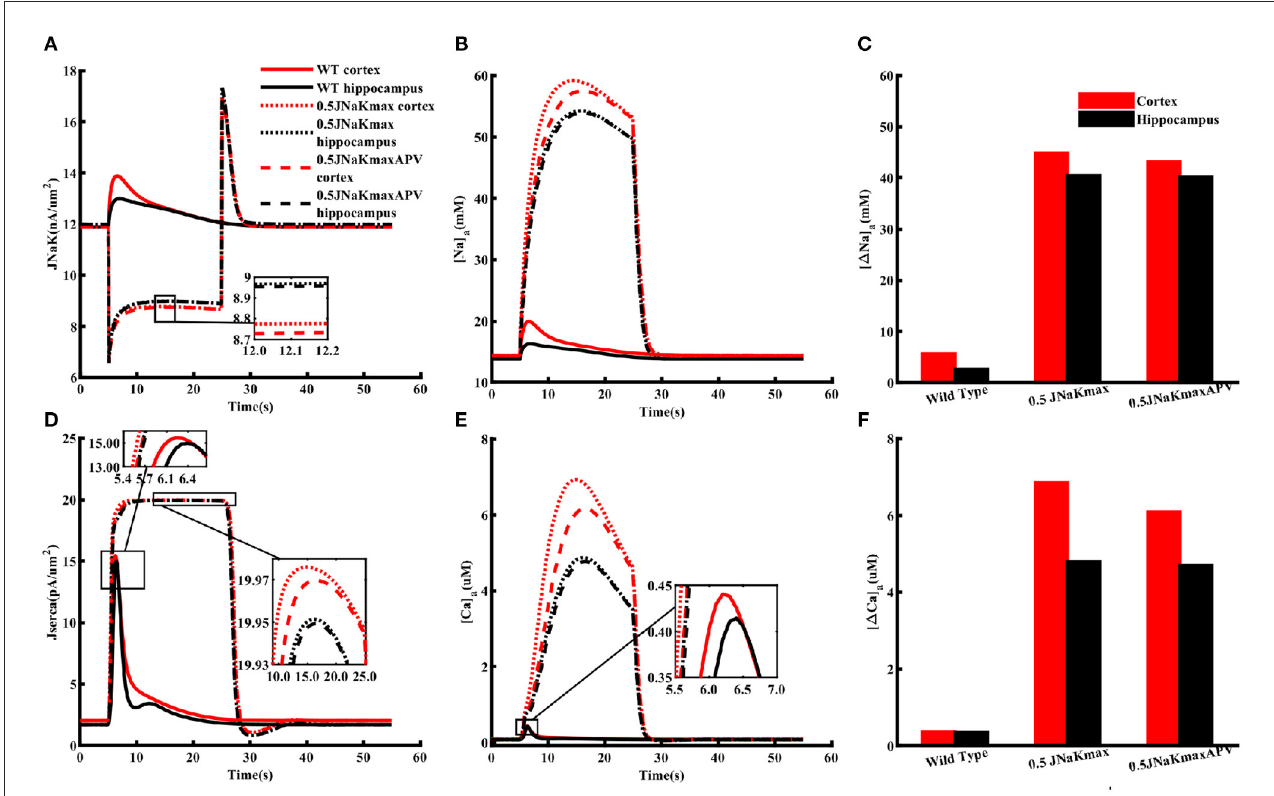
FIGURE6 Metabolic stress leaves cortical astrocytes more prone to Na + and Ca 2+ overload as compared to hippocampal astrocytes. Flux through Na + /K + pumps (A) and SERCA (D) under normal (WT) condition (solid lines), 20 s long metabolic stress where the peak capacity of Na + /K + -ATPase is reduced by 50% (dotted lines), and 20 s long metabolic stress in the presence of APV (dashed lines) in cortical (red) and hippocampal (black) astrocytes when both are exposed to 1 mM glutamate for 10 ms. (B) Na a and (E) Ca a from the simulation in (A) . Peak changes in Na a (C) and Ca a (F) during the simulations shown in (A) . Glutamate application and metabolic stress are initiated simultaneously. The insets are included to highlight the differences in various curves.